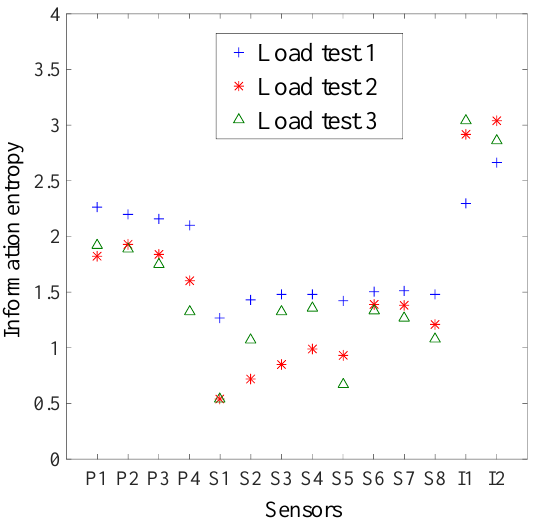
Figure 8. Sensor information entropy at each sensor location for each load test.